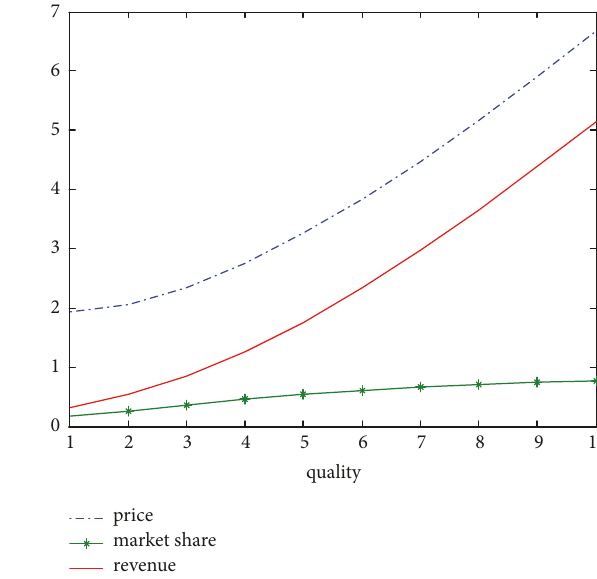
Figure 2: The variation of optimal solutions with the quality.